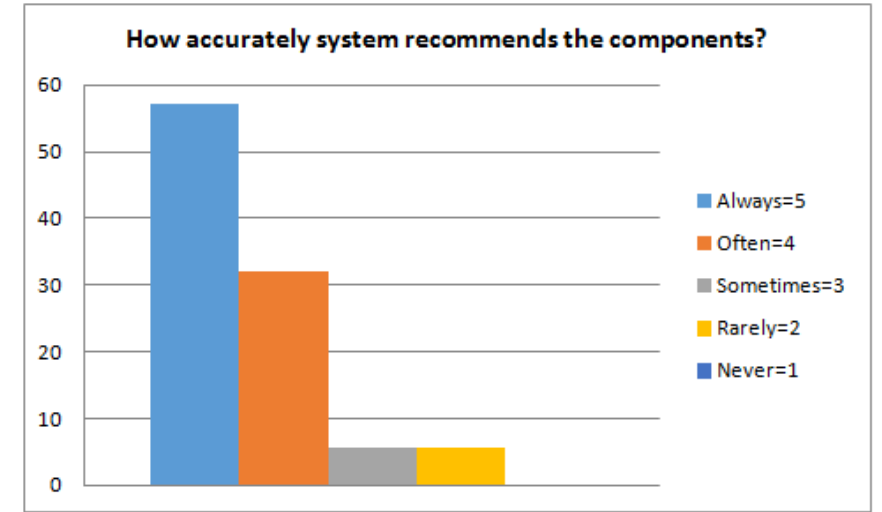
Figure 7. Accuracy of recommended components.